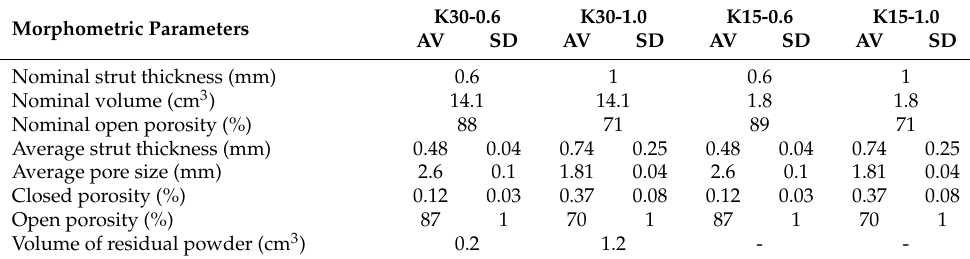
Table 6. The beads’ morphometric parameters determined by X µ CT analysis. The nominal values for strut thickness, volume, and open porosity are reported for reference. K30-0.6 Morphometric Parameters